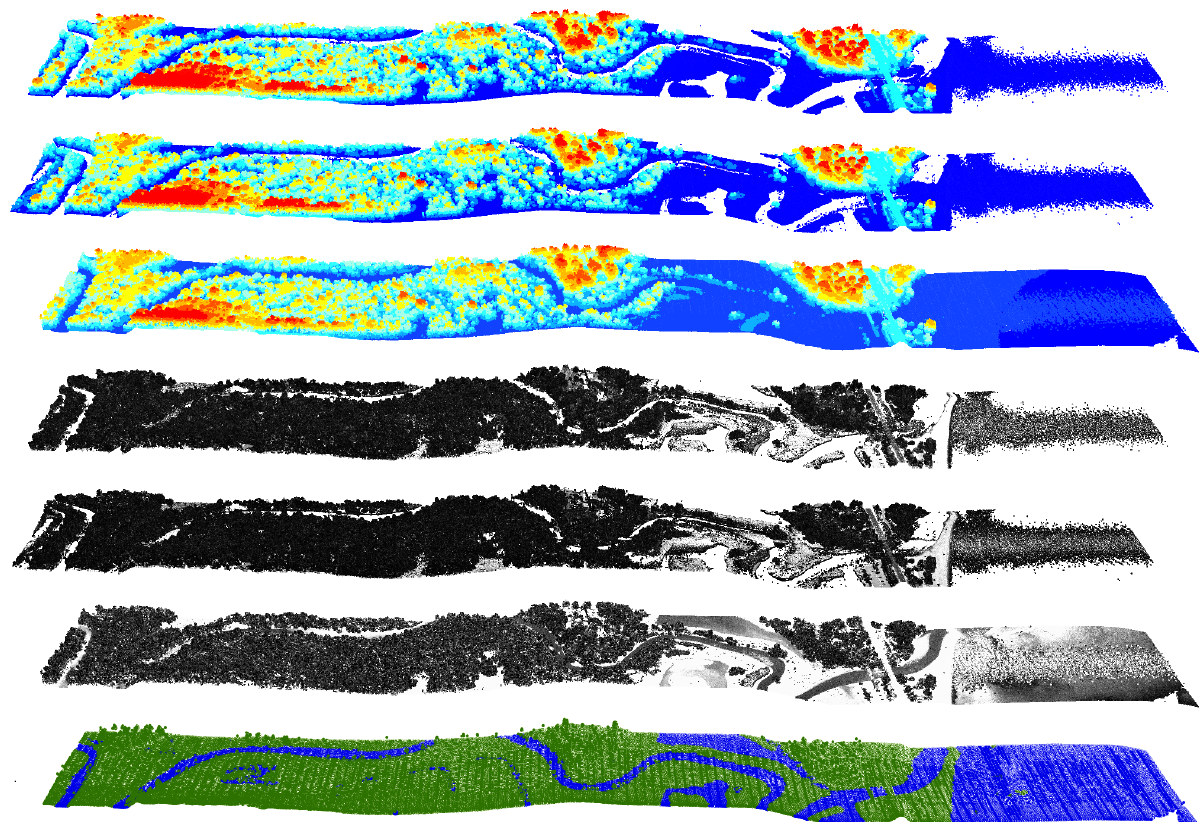
Figure 4. Second dataset - Rouge river (from top to bottom): LiDAR elevation displayed of channel 1 to 3, LiDAR intensity of channel 1 to 3 and classification result (green = land, blue =